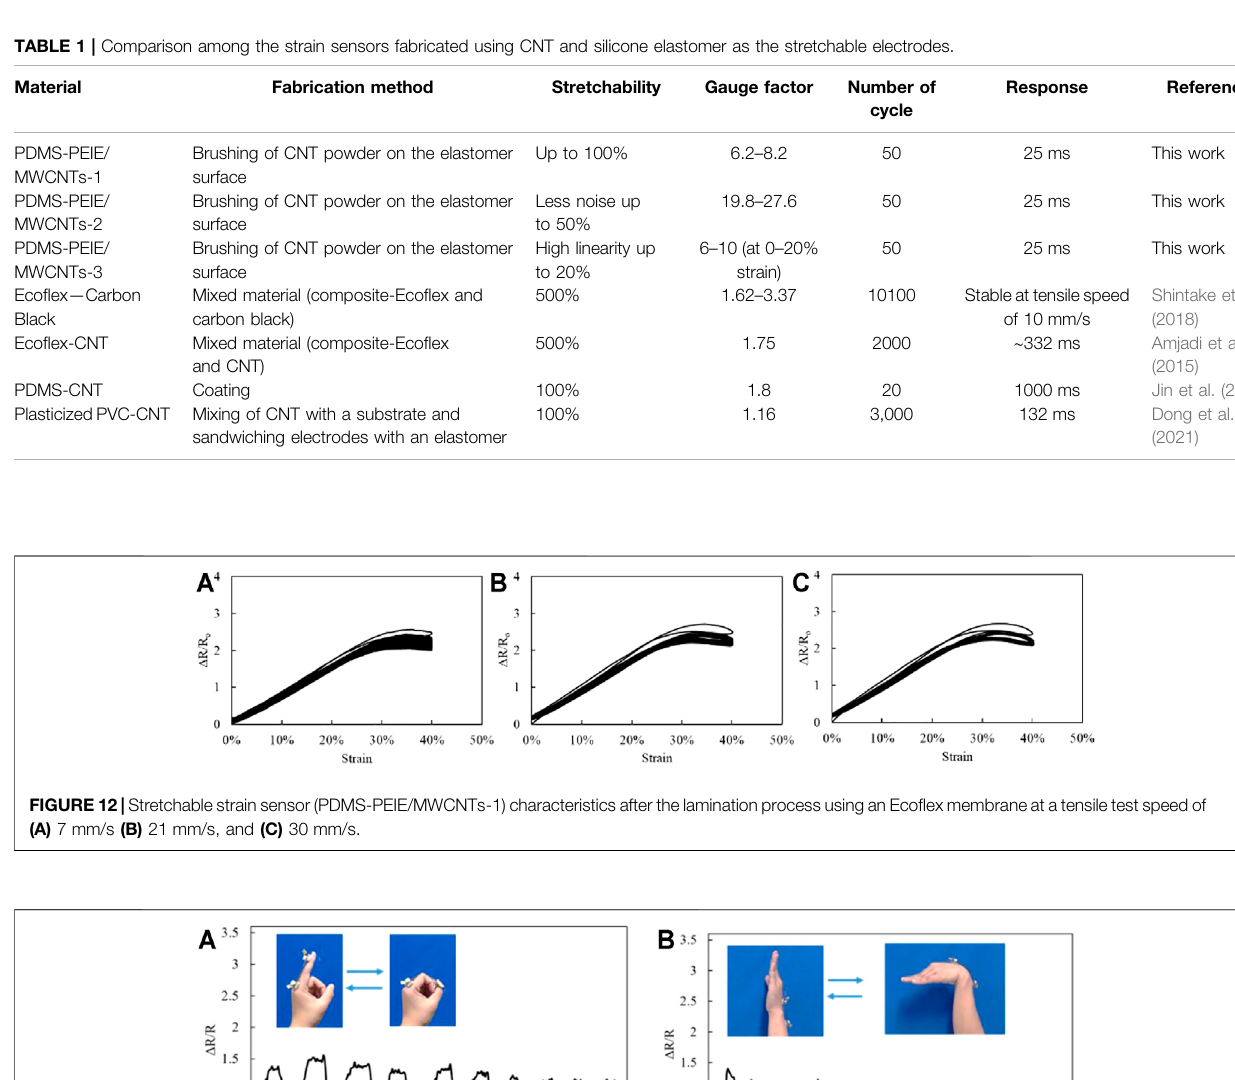
Frontiers in Robotics and AI |